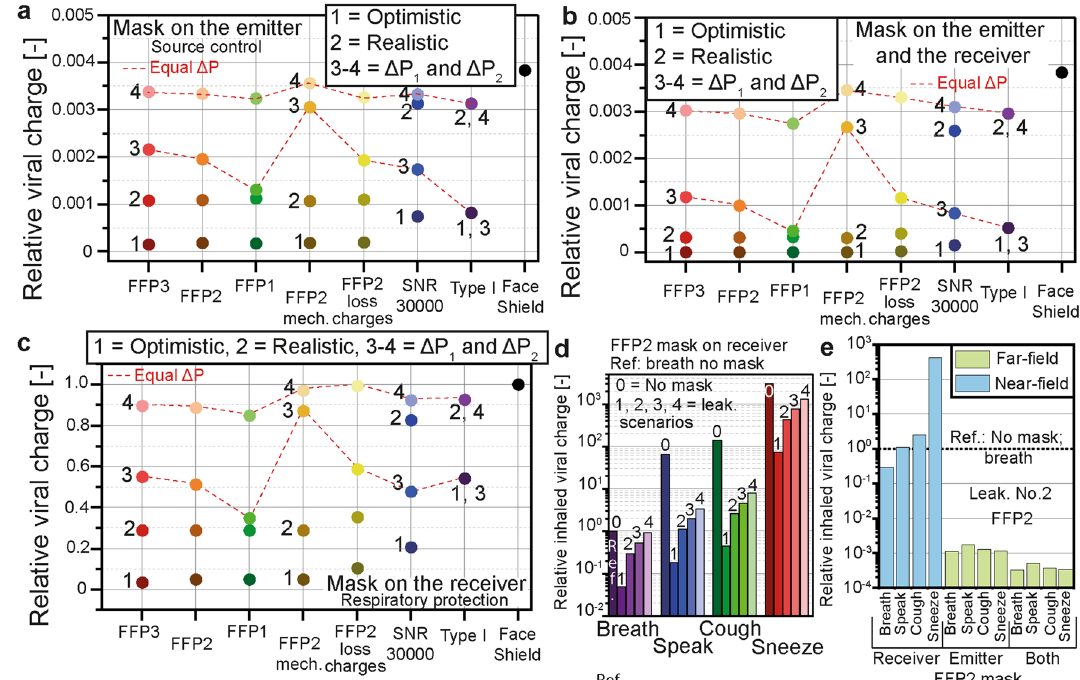
Figure 6. Influence of the leakage. The viral charge inhaled by the receiver located at 0.25 m from the receiver on the trajectory of the emitted airflow was calculated with different types of facemasks in several scenarios of leaking flows. The inhaled viral charge while breathing without a mask was taken as the reference. Scenario No.1 reflected an optimistic fit satisfying EN 149; No.2 represented a realistic fit; No.3 and 4 represented degraded fittings based on the hypothesis of equal breathing resistance for all the masks: the pressure drop was set to the value generated by a Type I mask in the optimistic fit scenario in No.3 and in the realistic fit scenario in No.4. The resulting exposure level, calculated as the sum of the near-field and far-field exposures, is given in ( a ) when only the emitter wore the mask ( source control), in ( b ) both the emitter and the receiver wore the masks, and in ( c ) only the receiver wore the mask (respiratory protection). All the levels of leakage applied to breathing, speaking, coughing, and sneezing are compared for a FFP2 mask on the receiver in ( d ). The no-mask scenario for the different expiratory activities is included for comparison and marked No.0. The breakdown of the inhaled viral charge into near-field and far-field exposures in the cases of speaking, coughing, and sneezing is given in ( e ) for leaking scenario No.2 for a FFP2